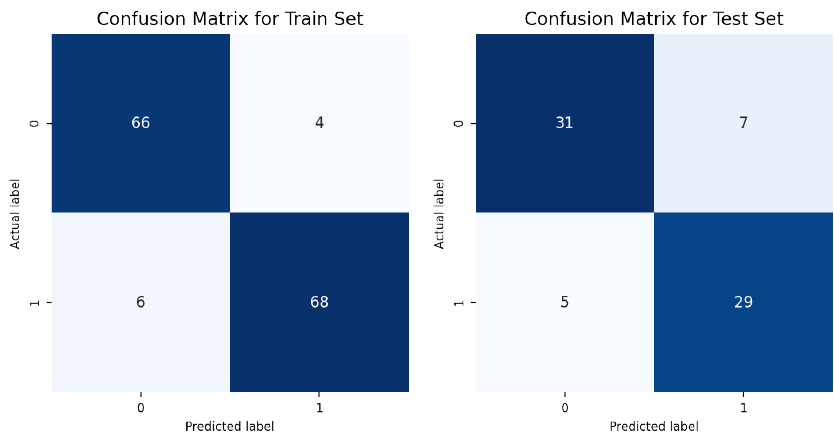
Figure 10. Model performance for prediciting the attention